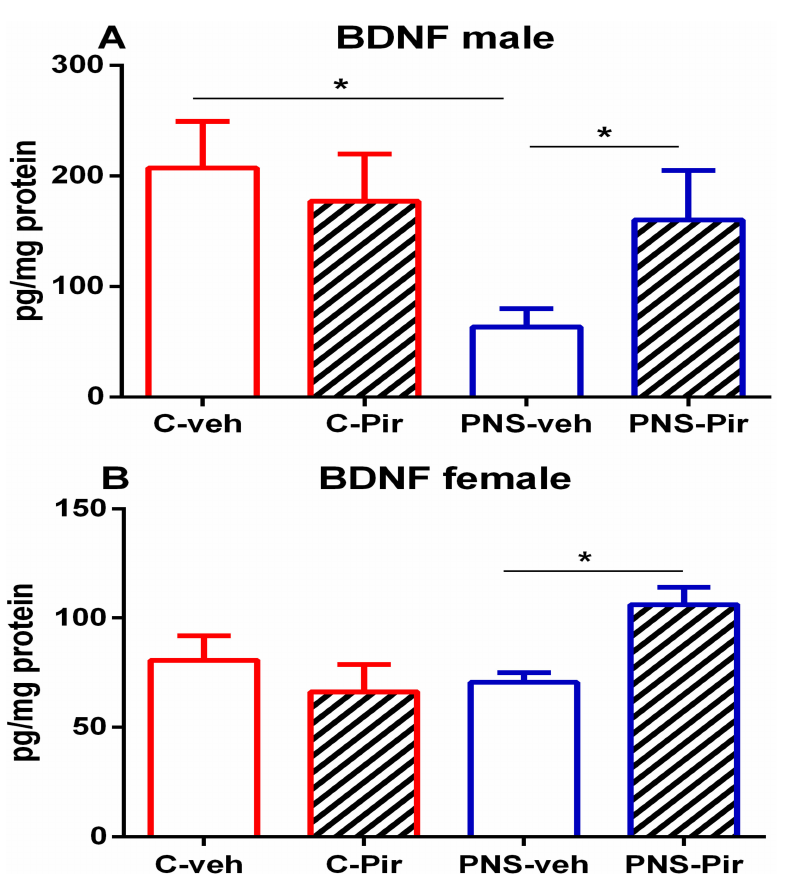
Figure 12. BDNF expression in male ( A ) and female ( B ) C-veh, C-Pir, C-Pir-Luz, PNS-veh, PNS-Pir and PNS-Pir-Luz group in the hippocampus. * p < 0.05 vs. C-veh, PNS-veh and PNS-veh group,